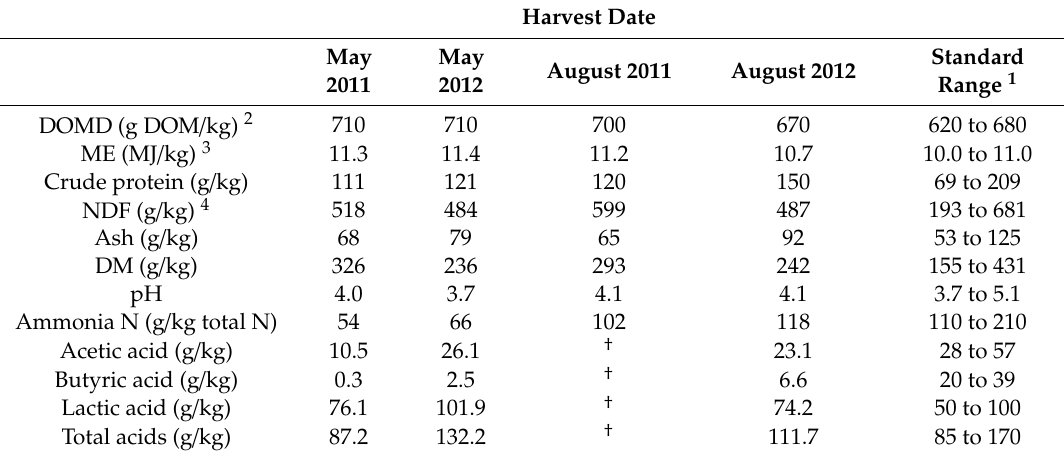
Table 4. Chemical analyses, reported on a dry matter (DM) basis, for silages made following harvest in 2011 and